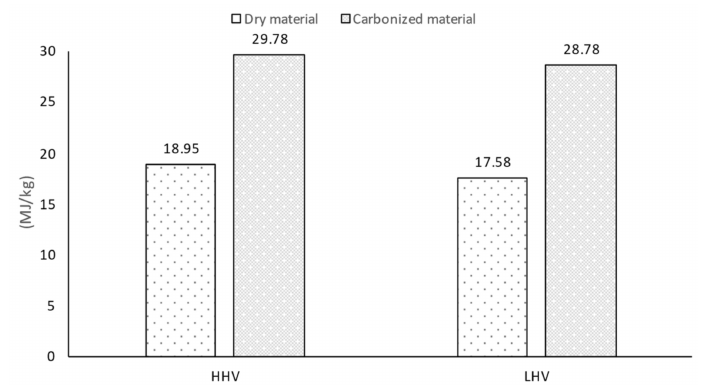
Figure 7. Evolution of HHV and LHV after carbonization of vine pruning.